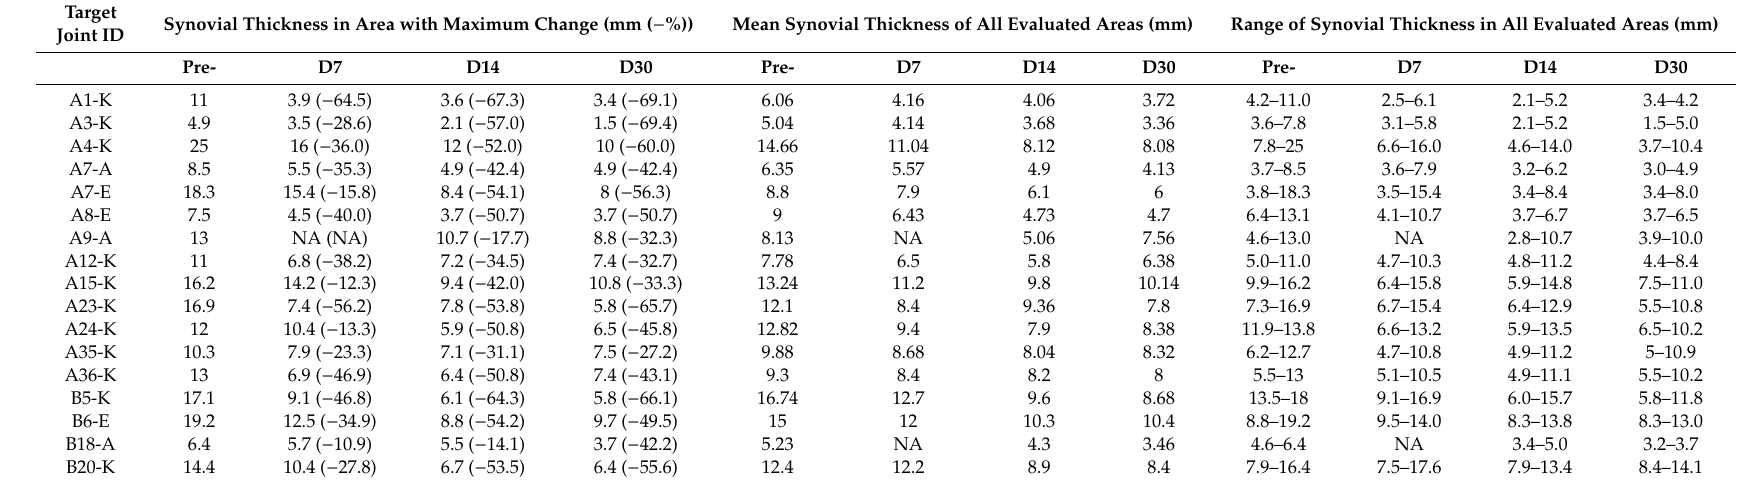
“Synovial thickness (mm) in area with maximum change” displayed in the left panel. Values in parentheses represented the percentage decrease compared to thickness pre-treatment for each patient. “NA”: No data collected. For “Synovial thickness (mm) in the area with maximum change”, p all < 0.001 for comparisons: “d7” vs. “pre”, “d14” vs. “pre”, and “d30” vs. “pre”. For “Mean synovial thickness of all evaluated areas”, p = 0.39 for “d7” vs. “pre”; p < 0.01 for “d14” vs. “pre”; p < 0.01 for “d30” vs.